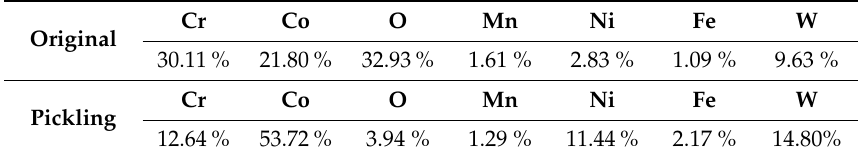
Table 4. Chemical composition on the oxygen cuts surface. Table 5. Chemical composition on the argon cuts